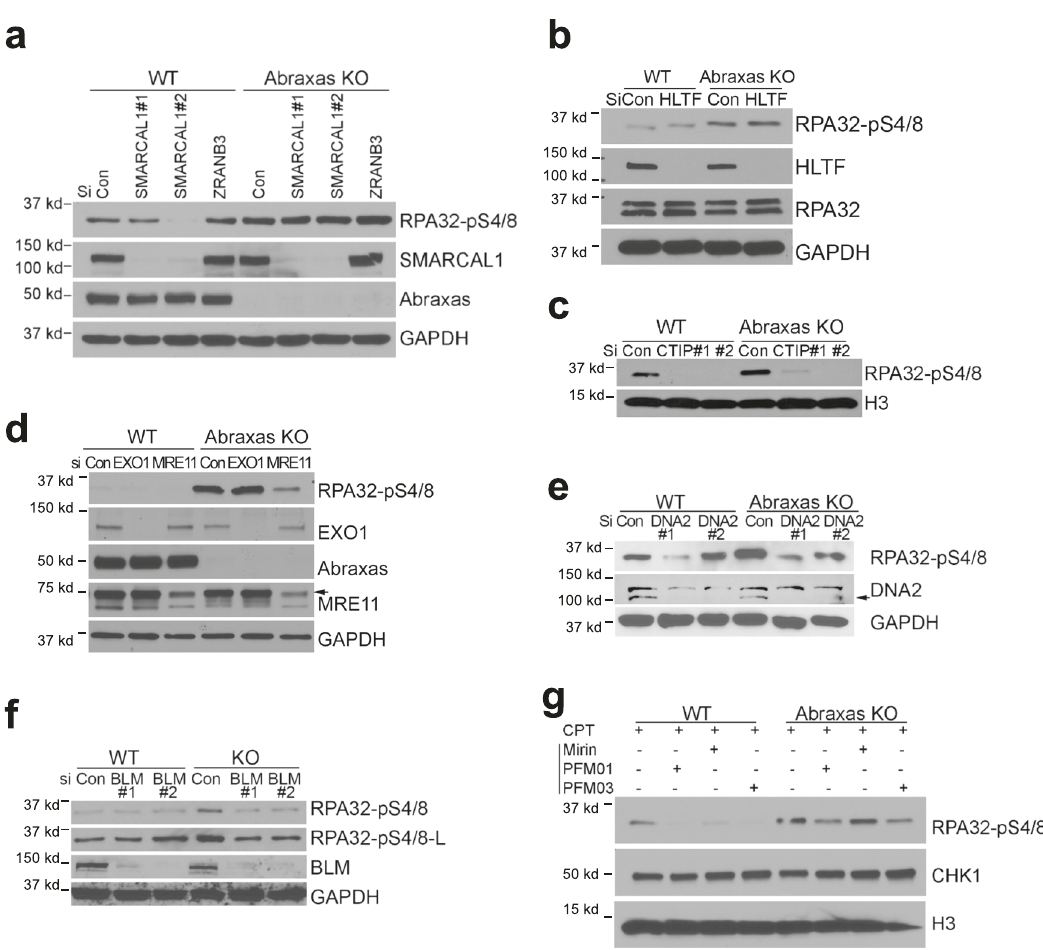
Fig. 4 Increased resection in Abraxas-de fi cient cells is independent of fork reversal but requires MRE11 endonuclease, CtIP, and DNA2/BLM. a SMARCAL1 and ZRANB3 depletion does not rescue CPT-induced hyperphosphorylation of RPA in Abraxas KO cells. Data of additional siRNAs to SMARCAL1 are in Supplementary 4a. b HLTF depletion does not rescue CPT-induced hyperphosphorylation of RPA in Abraxas KO cells. c Knocking down CtIP reduced the elevated RPA32-pS4/8 levels in Abraxas KO cells treated with CPT. CtIP knockdown ef fi ciency is shown in Supplementary Fig. S4. d Knocking down MRE11 but not EXO1 reduced the elevated RPA32-pS4/8 levels in Abraxas KO cells treated with CPT. e Knocking down DNA2 reduced the elevated RPA32-pS4/8 levels in Abraxas KO cells treated with CPT. Data of additional siRNAs to DNA2 are in Supplementary Fig. 4a. f Knocking down BLM reduced the elevated RPA32-pS4/8 levels in Abraxas KO cells treated with CPT. g MRE11 endonuclease activity but not exonuclease activity is required for increased RPA32-pS4/8 levels in Abraxas KO cells upon CPT treatment. MRE11 endonuclease inhibitors PFM01 and PFM03 (100 μ M)